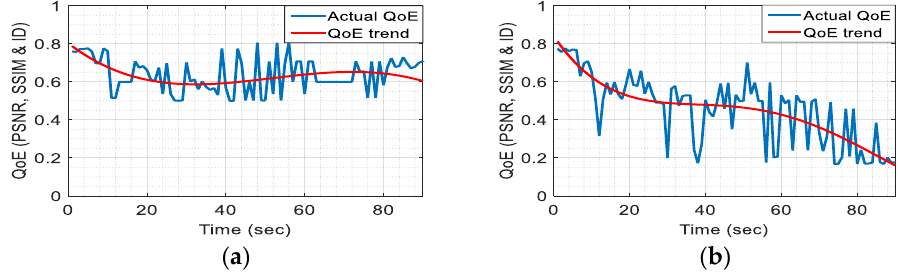
Figure 14. Video quality determined by FIS2: ( a ) Full image and ( b ) partitioned image.